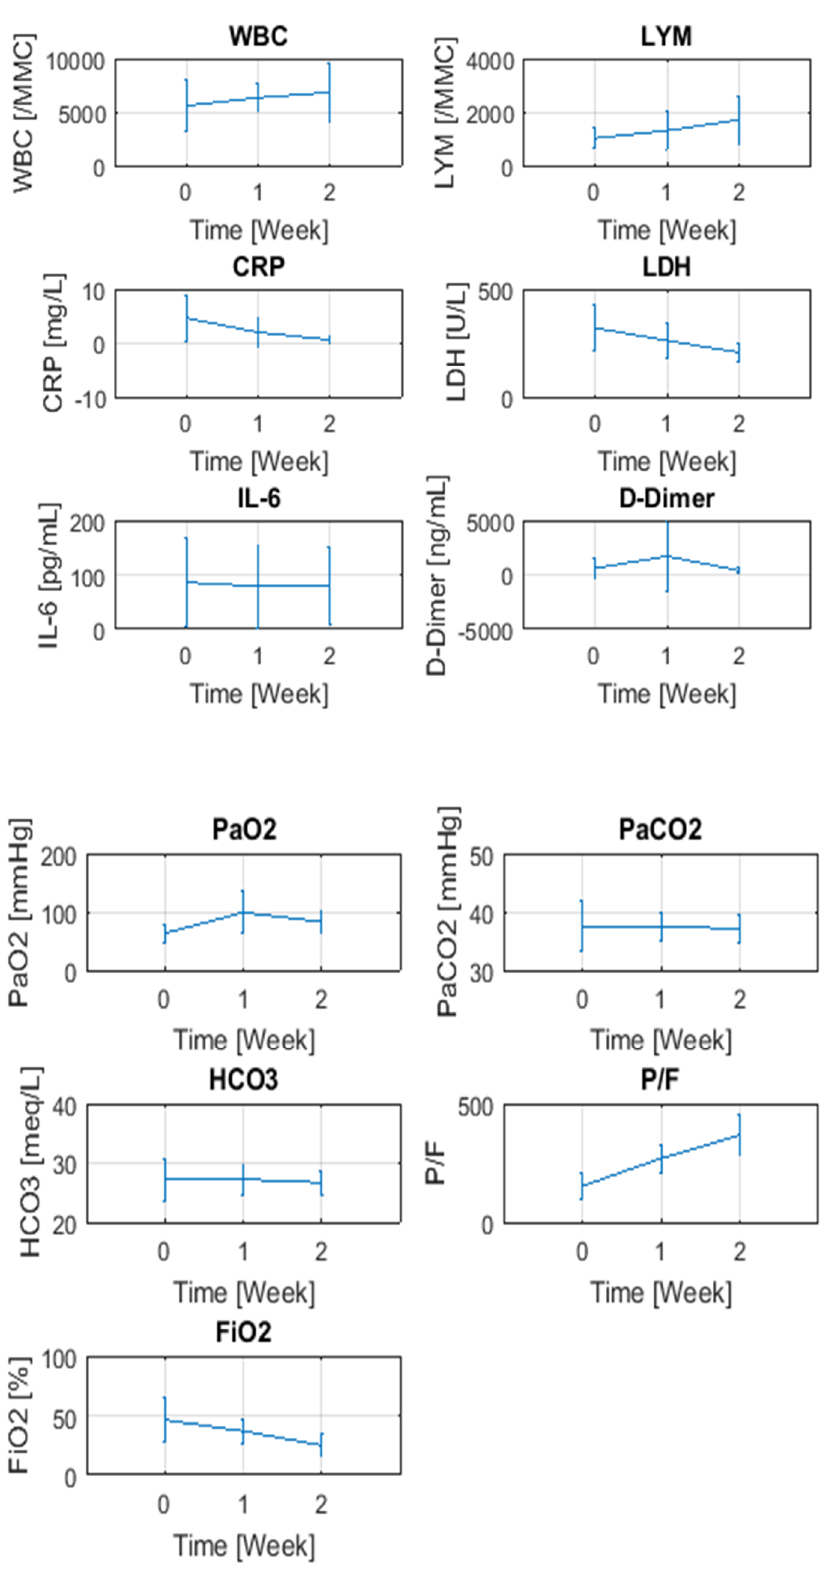
Figure 4. Changes in blood tests and clinical indicators over time.